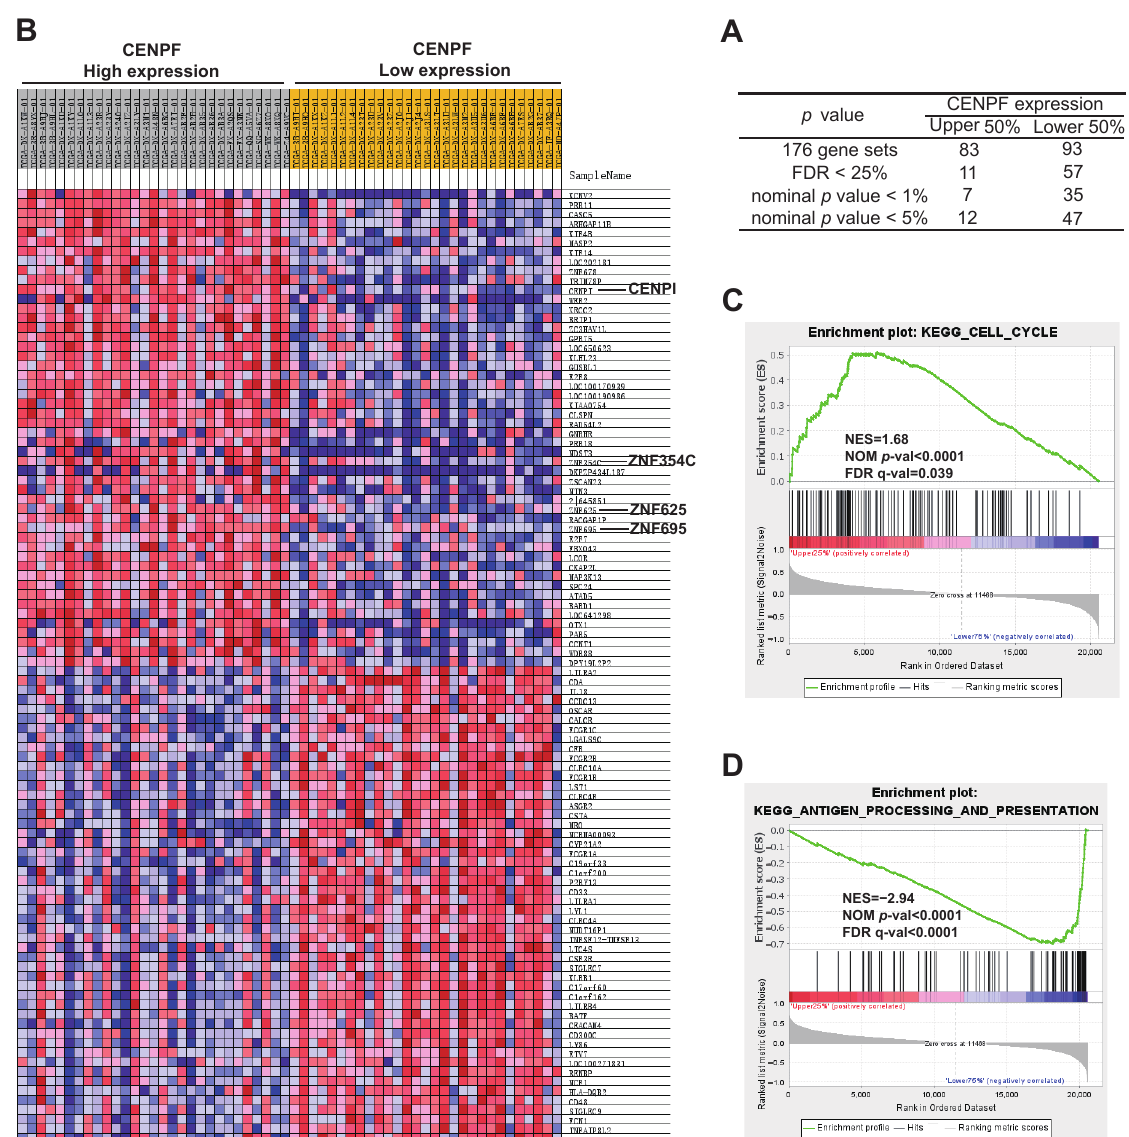
Figure 6. Gene set enrichment analysis (GSEA) of CENPF . ( A ) A summary of GSEA analysis. Patients were classified into two subgroups according to CENPF expression (upper 50% vs. lower